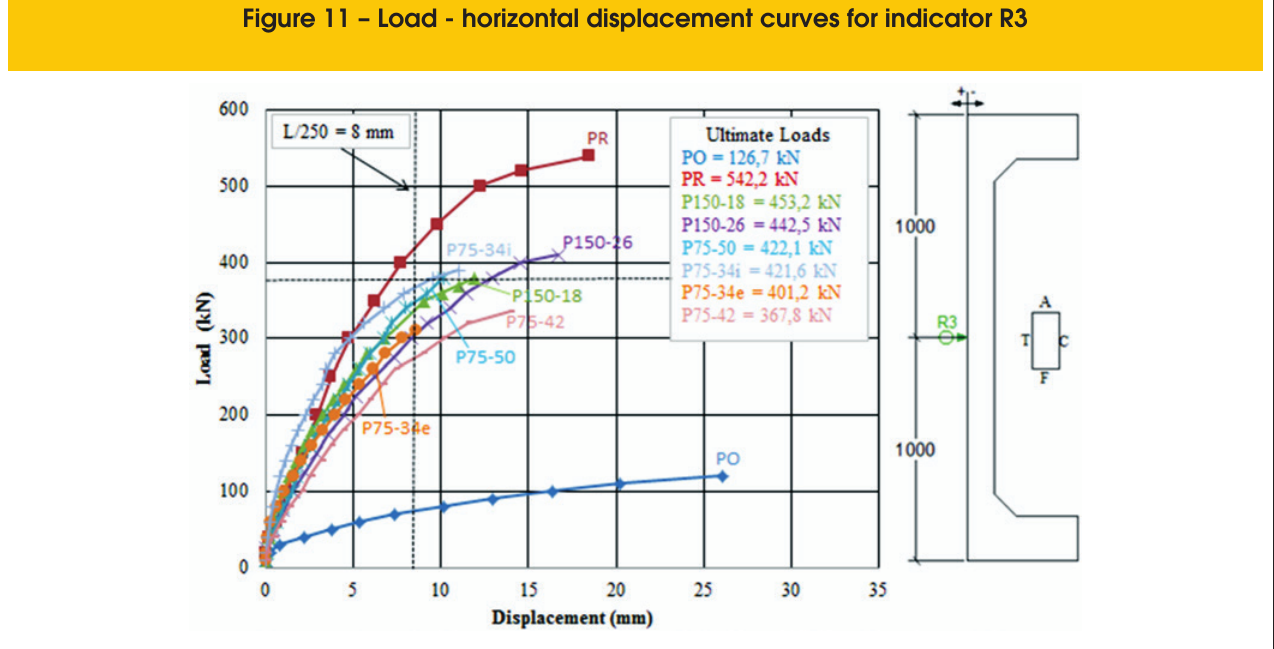
Figure 11 – Load - horizontal displacement curves for indicator